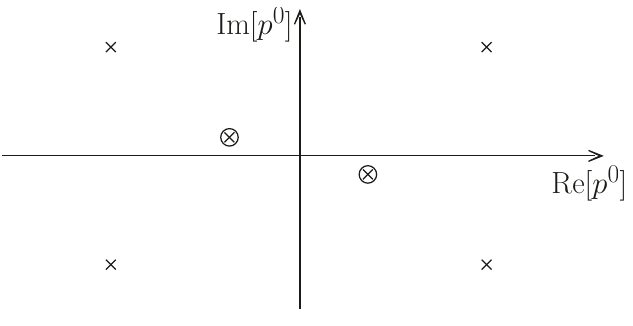
Figure 1 . Poles of the